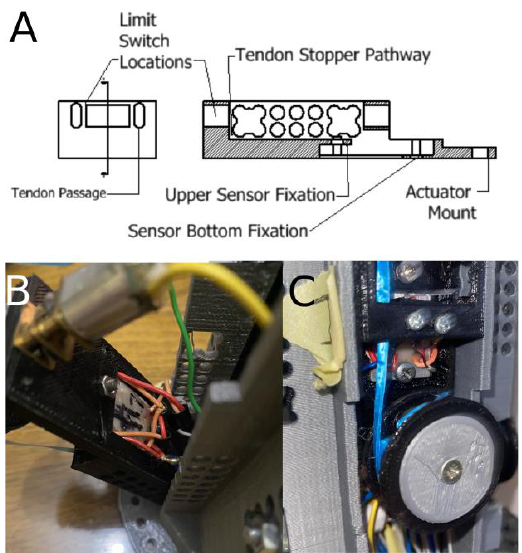
Figure 8. Diagram illustrating how the test specimen is embedded inside the actuation module body. ( A ) Engineering drawing showing the cavity in which the test specimen is embedded. ( B ) The test specimen as seen from the actuation module from the back. ( C ) The test specimen as seen from actuation module from the front.